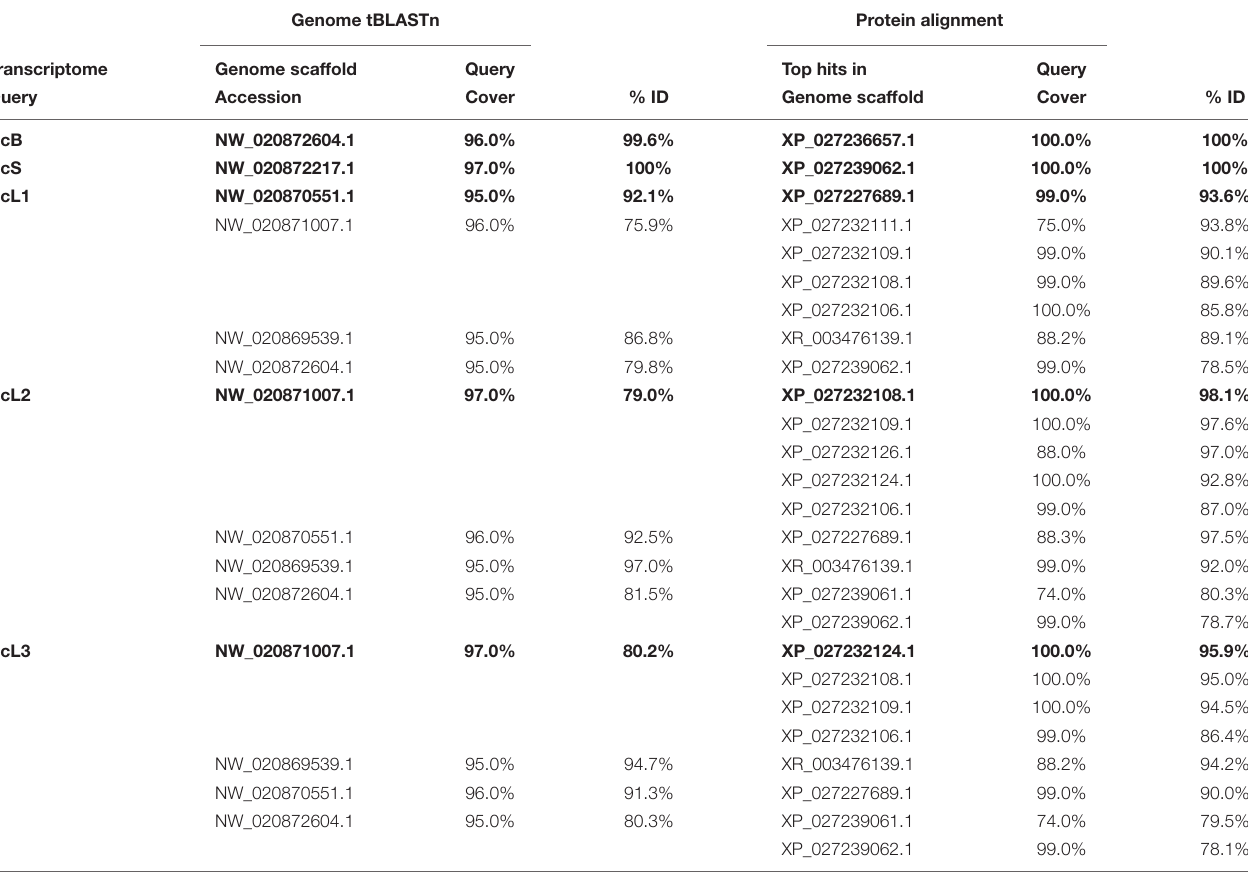
TABLE 1 | Alignments of hemocyanin isoforms identified in L. vannamei transcriptomes (Johnson et al., 2015) to isoforms in the reference genome assembly ASM378908v1 (Zhang et al., 2019). Genome tBLASTn Protein